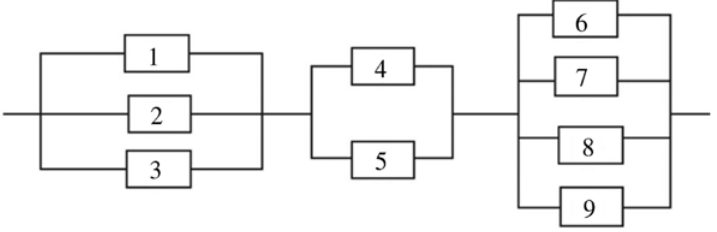
Figure 3: Block Diagram of the Coal Feeding System with Nine Conveyors.